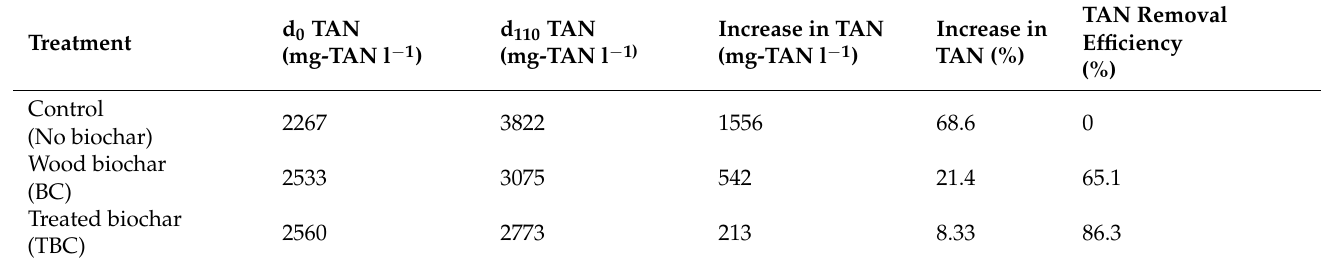
Table 2. The total ammonia nitrogen (TAN) concentration and TAN removal efficiency of the experimental treatments at the start of the experiment (d 0 ) and the end of the experiment (d 110